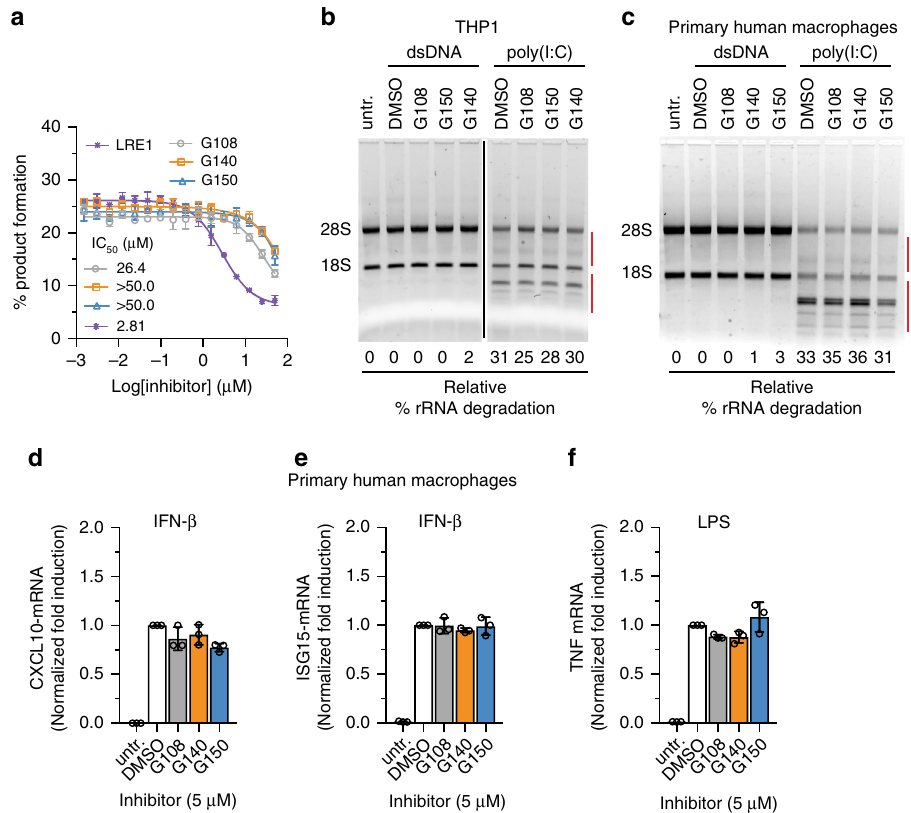
Fig. 8 G chemotype inhibitors show no off-target effect against other nucleotidyl transferase enzymes. a Biochemical off-target assessment of cGAS inhibitors using soluble adenylyl cyclase enzyme. b , c Cellular off-target effect assessment of cGAS inhibitors against OAS proteins using 2 µ g ml − 1 poly (I:C) as a ligand to stimulate OAS-RNaseL pathway in THP1 cells ( b ) and primary human macrophages ( c ). Red bars encompass the degraded rRNAs that were used for the quanti fi cation of relative percentage (%) rRNA degradation. d – f Off-target analysis of 5 µ M G108, G140 , and G150 against cGAS inhibition in primary human macrophage cells differentiated from human blood-derived monocytes using different ligands: 1000 U ml − 1 recombinant human interferon- β (IFN- β ) (JAK/STAT), or 2 µ g ml − 1 LPS (TLR4) ( n = 3; mean ± S.D. Data shown are representation of two independent experiments ( a , b , d – f